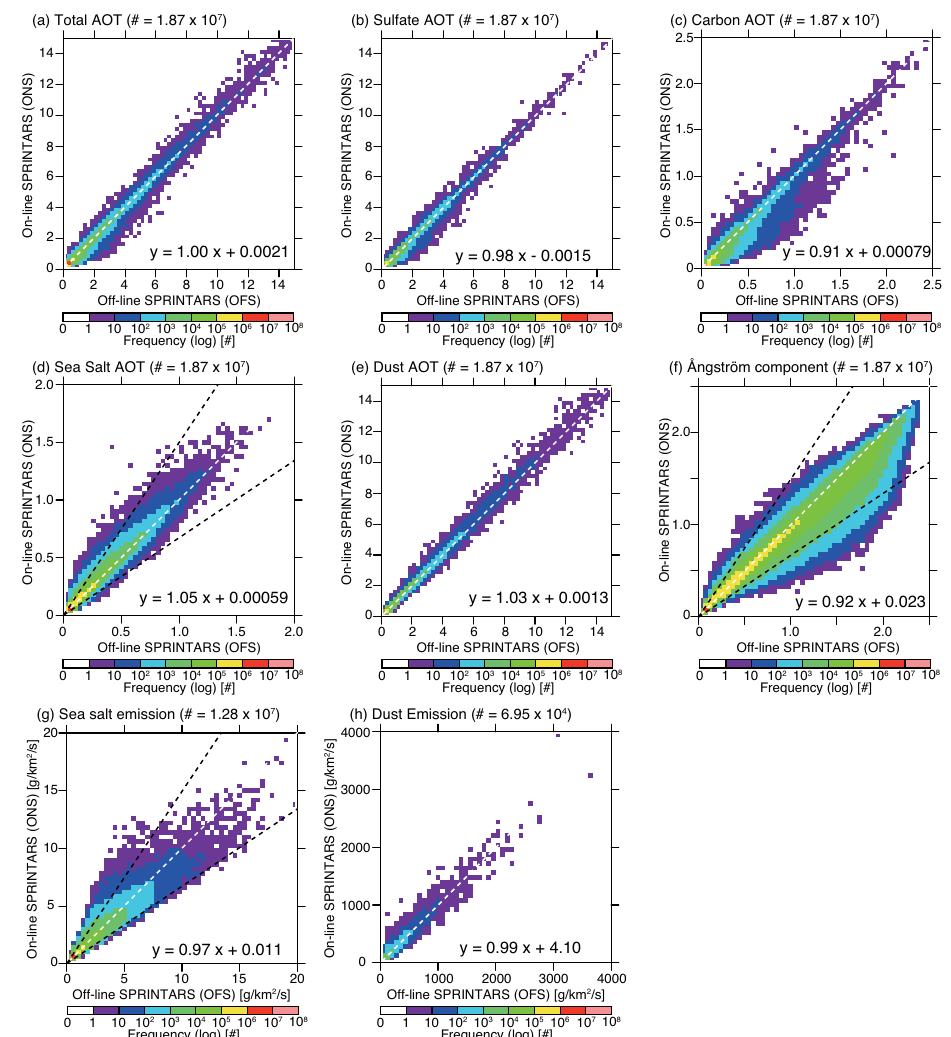
Fig. 2. Scatter plots of ONS versus OFS results for aerosol optical thicknesses of (a) total, (b) sulfate, (c) carbonaceous, (d) sea-salt, and (e) dust aerosols; (f) Ångstöm components; and natural aerosol emissions for (g) sea-salt and (h) dust aerosols. Colours denote frequency of occurrence on a log scale. The white broken line is the 1 : 1 line and the black broken lines denote the 1.5 : 1 and 1 : 1.5 lines.